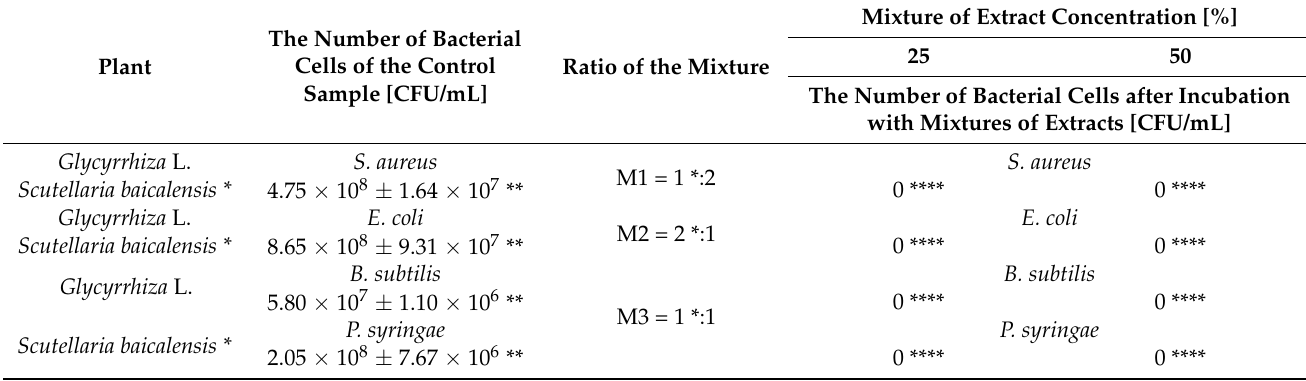
Table 6. The influence of mixtures of S. baicalensis and Glycyrrhiza L. extracts on the viability of S. aureus , E. coli , P. syringae and B. subtilis . Mixture of Extract Concentration [%] The Number of Bacterial 25 50 Cells of the Control Plant Ratio of the Mixture Sample [CFU/mL] The Number of Bacterial Cells after Incubation with Mixtures of Extracts [CFU/mL] Glycyrrhiza L. Scutellaria baicalensis * 0 **** Glycyrrhiza L. E. coli M2 = 2 *:1 Scutellaria baicalensis * Glycyrrhiza